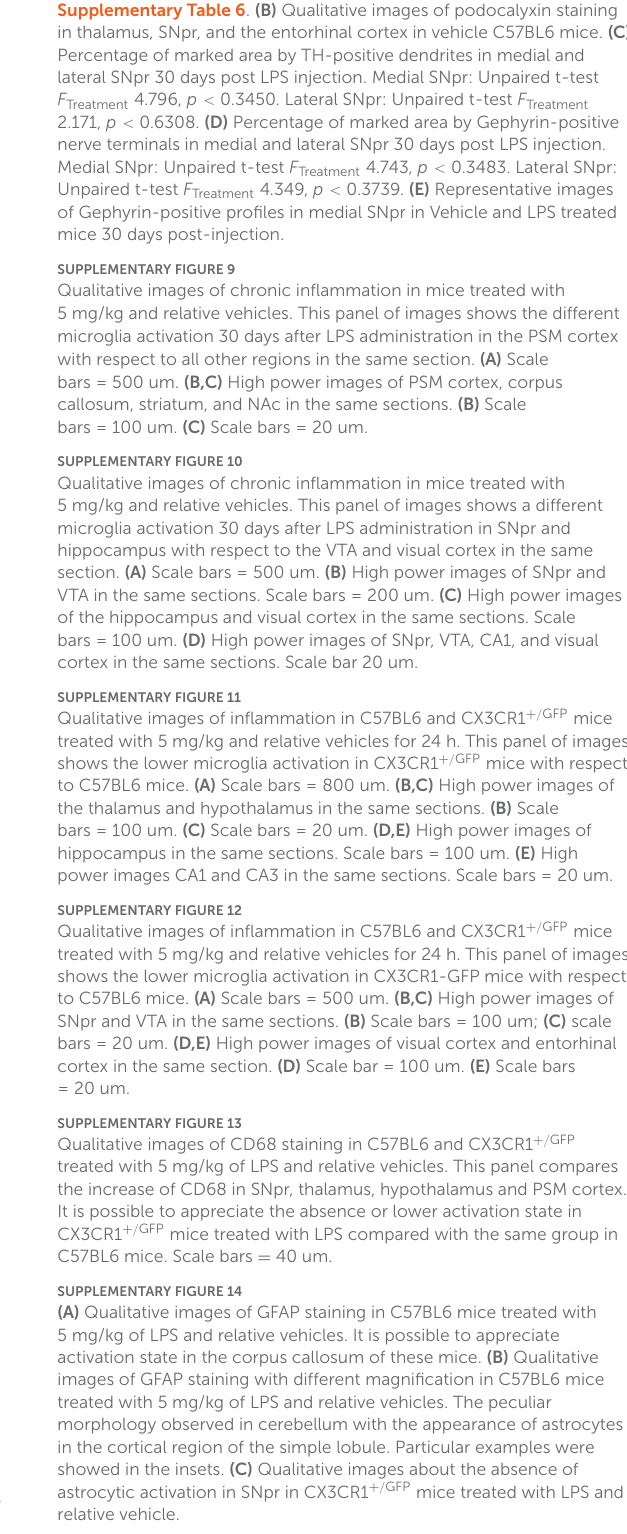
Supplementary Table 6 . (B) Qualitative images of podocalyxin staining in thalamus, SNpr, and the entorhinal cortex in vehicle C57BL6 mice.